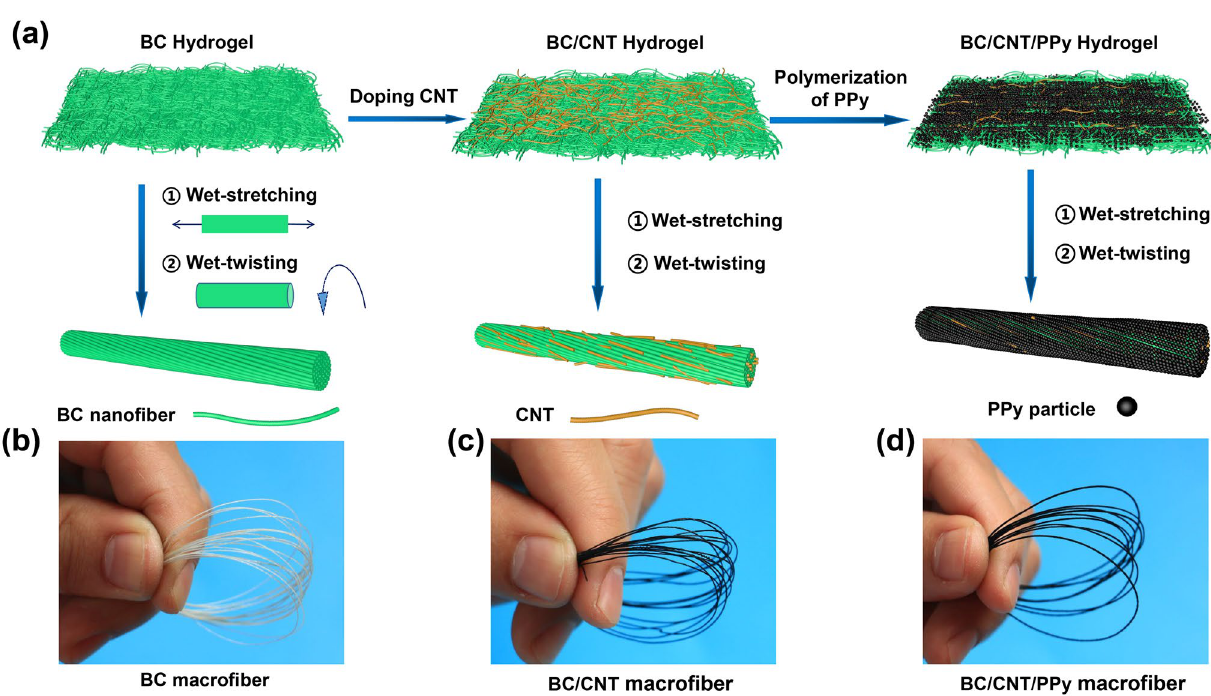
Fig. 1 a Schematic illustration of BC, BC/CNT, BC/CNT/PPy macrofibers fabrication. The photographs of b BC, c BC/CNT, and d BC/CNT/ PPy